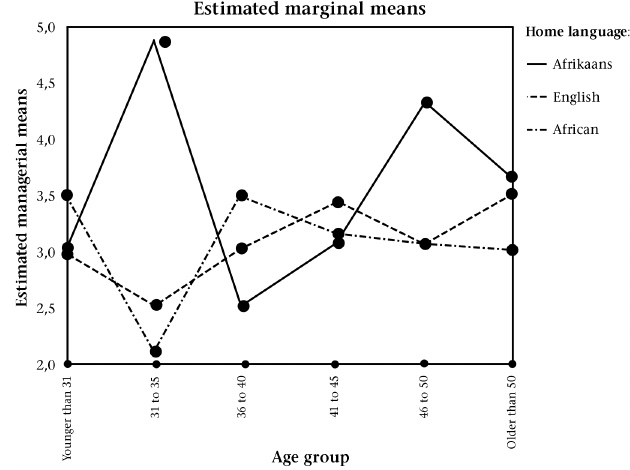
Figure 8: Biographical variables: Gender × Race as predictors of the perceptions of black economic empowerment